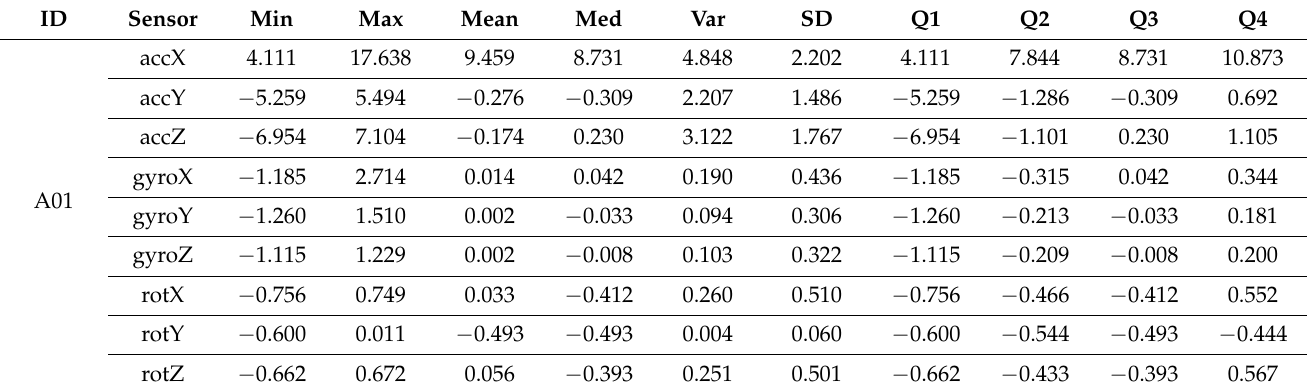
Table 2. Statistical information of A01 subject’s